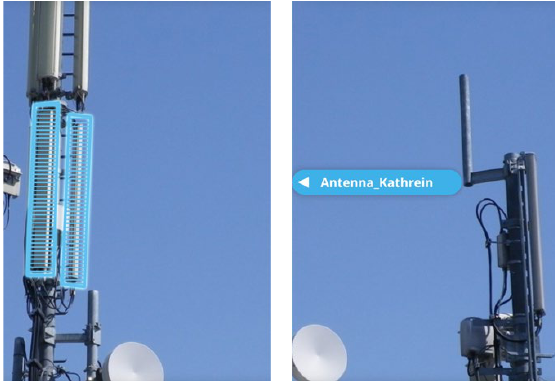
Figure 5. Graphic representation of one of the proposed user interface functions. When a selected object is off the field of view, an arrow on the edge of the screen can direct the user.